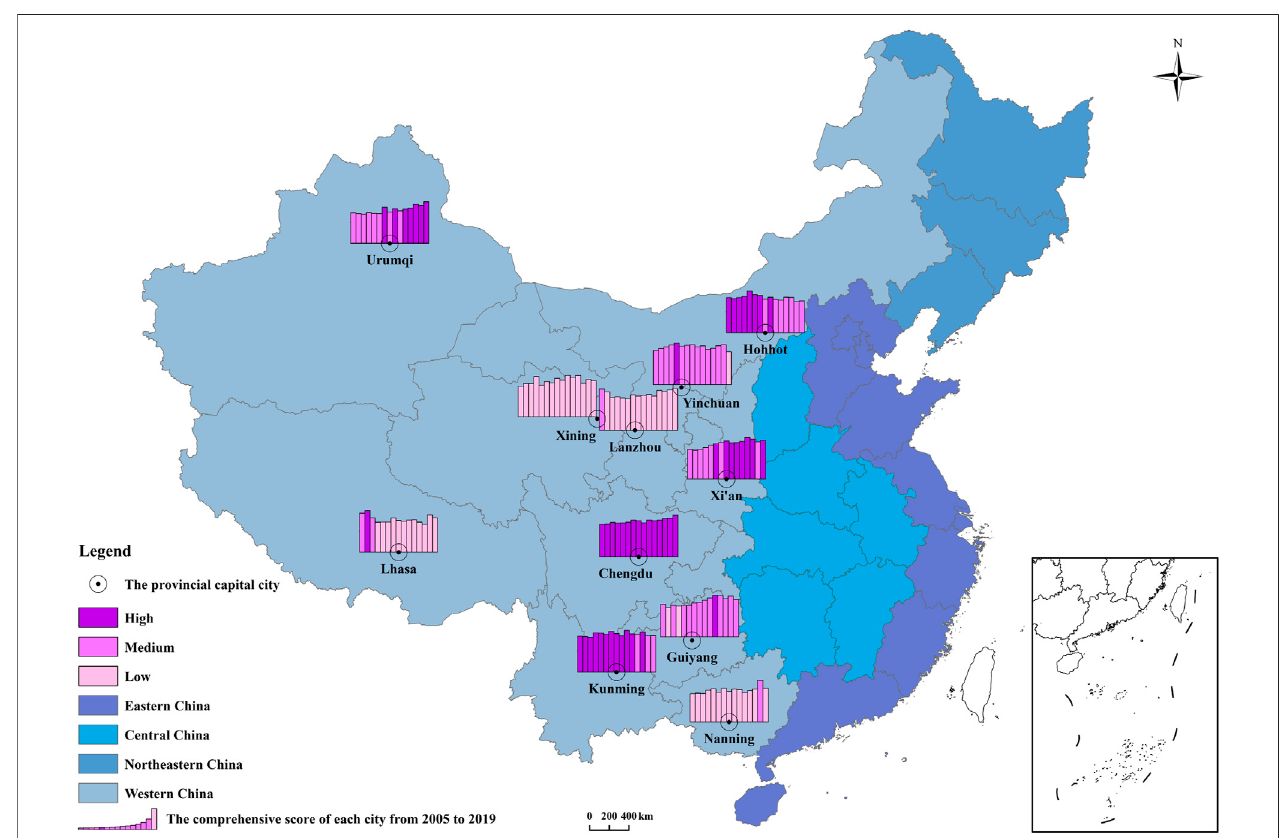
FIGURE 5 | Spatial distribution of new urbanization in western provincial